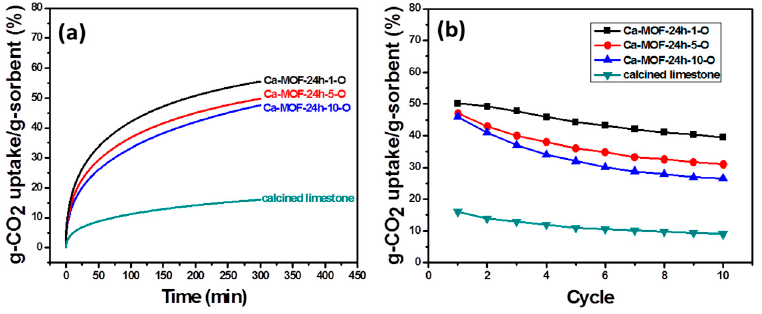
Figure 8. ( a ) CO 2 capture kinetics at 450 °C and ( b ) multiple carbonation–calcination cycles of Ca-MOF-24h-y-O and calcined limestone.